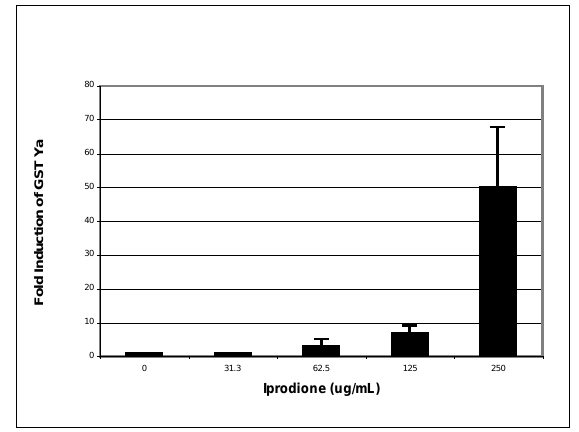
Fig. 2: Fold induction of GST Ya in HepG